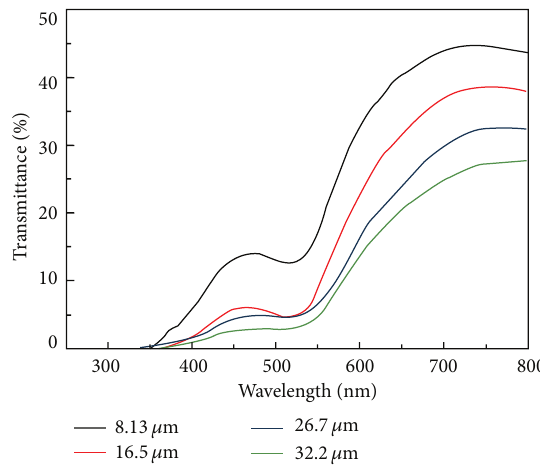
Figure 2: Transmittance of DSC with different TiO 2 thicknesses [6].